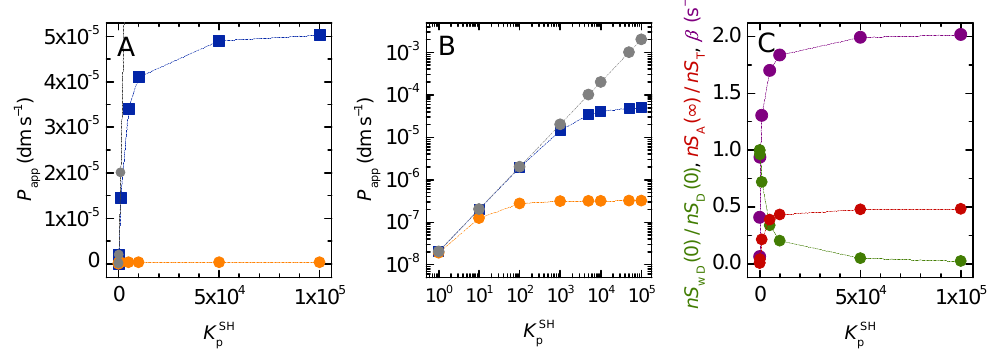
Figure 12. Calculated permeability coefficient as a function of solute lipophilicity ( P app (cid:4) , P w app • , and P w ∗ app • ), in Cartesian ( A ) and log-log ( B ) scales. ( C ) Equilibration characteristic constant ( β • ), fraction of solute in the aqueous compartment at t = 0 ( nS wD ( 0 ) / nS D ( 0 ) • ), and fraction of solute in the acceptor compartment at equilibrium ( nS A ( ∞ ) / nS T • ). The dotted lines are guides for the eye. As the solute lipophilicity increases, P w underestimates the solute dynamics and the app calculated value of this permeability coefficient is much smaller than P (Plots A and app